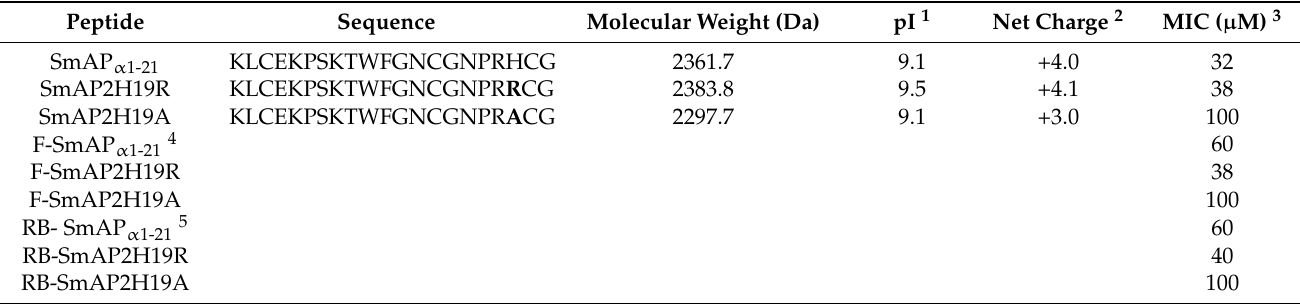
Table 1. Main properties of SmAP α 1-21 derived